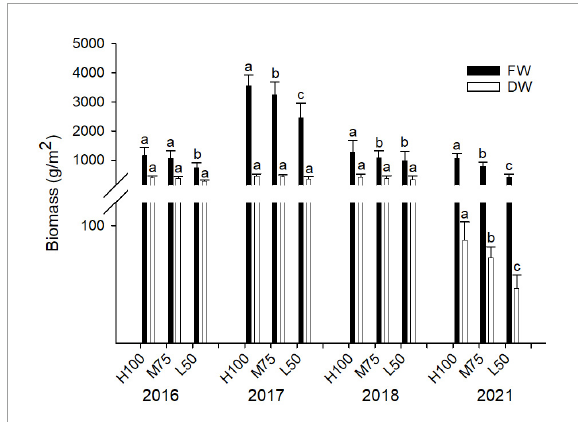
FIGURE1 Fresh and dry weight of plant biomass in agretti grown for 4 years on saline, B- and Se-laden soil and irrigated with either low-saline water (2016 and 2017) or saline water (2018 and 2021). Statistical difference was performed to analyze the effect of irrigation levels within each planting year (H100 = high 100% Et o , M75 = medium 75% Et o , and L50 = low 50% Et o ) as described in Table 3 . Values represent averages ( n = 12 for 100% Et o , n = 9 for 75% and 50% Et o for planting in 2016; n = 19 for 100% Et o , n = 17 for 75% for planting in 2017; n = 18 for planting in 2018, n = 4 for planting in 2021). Values of n varies amongst year because of the variability in seed germination and plantlets survival in the field. and error bars represent standard deviation. Different letters indicate that values differed significantly ( P ≤ 0.05), ns = not